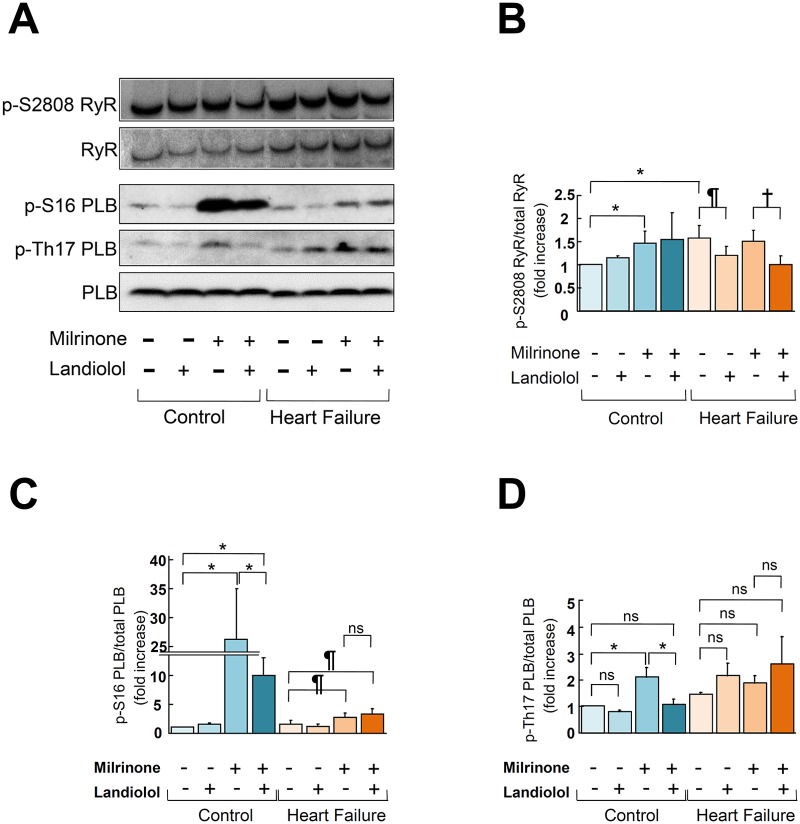
Immunoblots of phosphorylated RyR (Ser2808), total RyR2, phosphorylated PLB (Ser16, Thr17), and total PLB in normal and failing cardiomyocytes.A. Representative data. B, C, D. The corresponding bar graphs, with bars indicating the mean (SE). The results of the quantitative analysis are expressed relative to the control (baseline) value, which was designated as 1 (n = 6 in each group). * P<0.05 vs. control (baseline), ¶
P<0.05 vs. failure (baseline), †
P<0.05 vs. failure (monotherapy with milrinone).